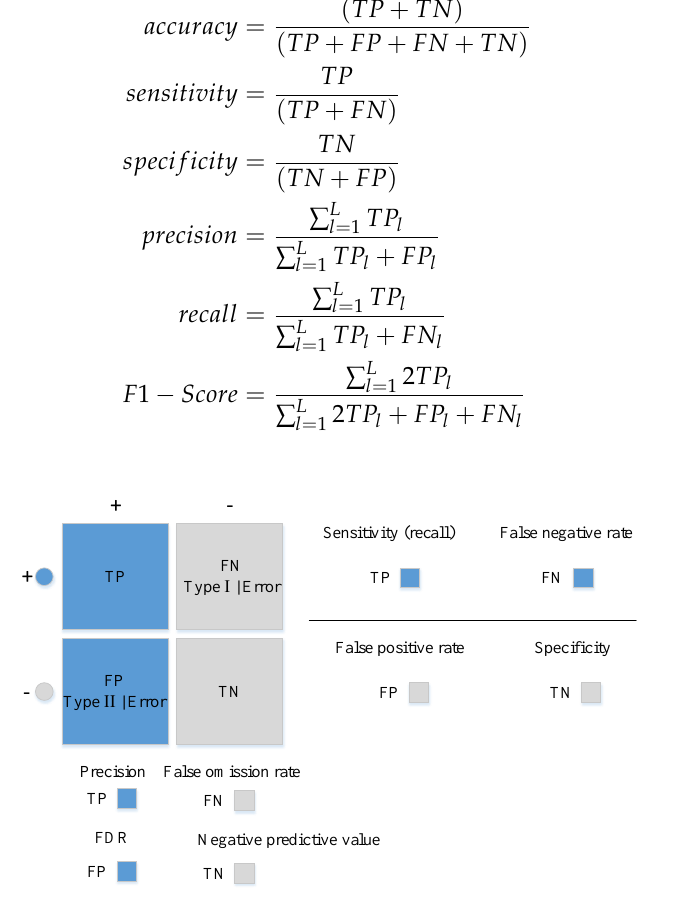
Figure 24. Confusion